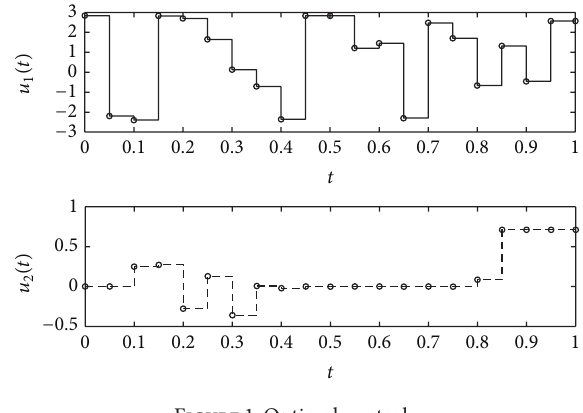
Figure 1: Optimal controls.